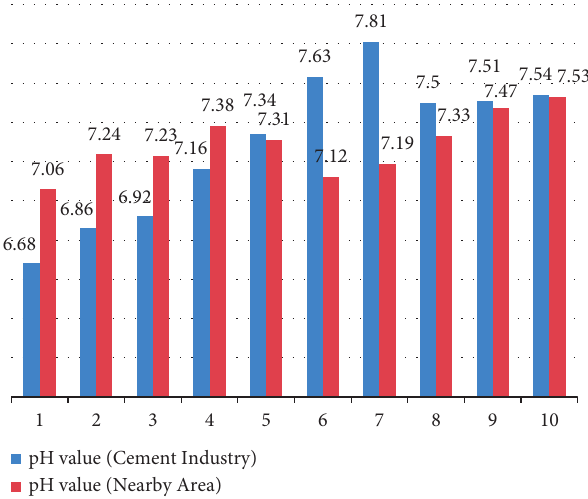
Figure 2: pH results of soil samples collected from the cement industry and its nearby